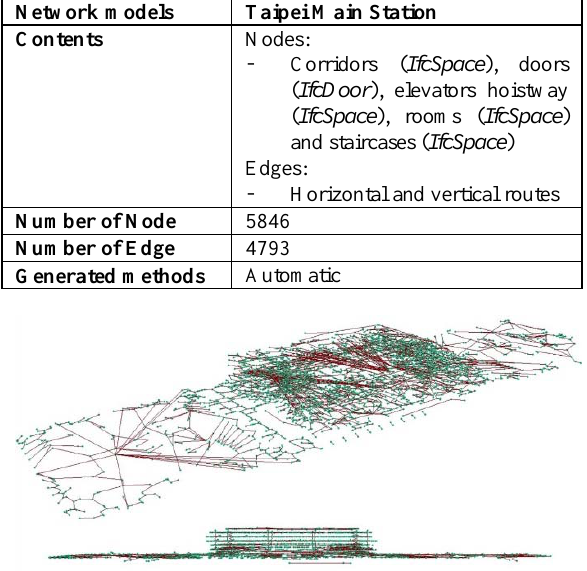
Figure 5. Network model of Taipei Main